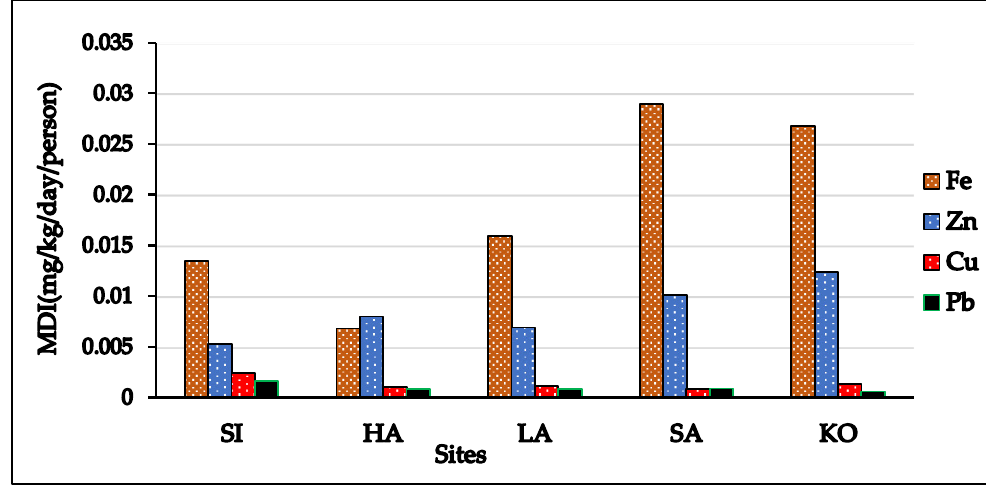
Figure 4. MDI of heavy metals in roof-harvested rainwater.